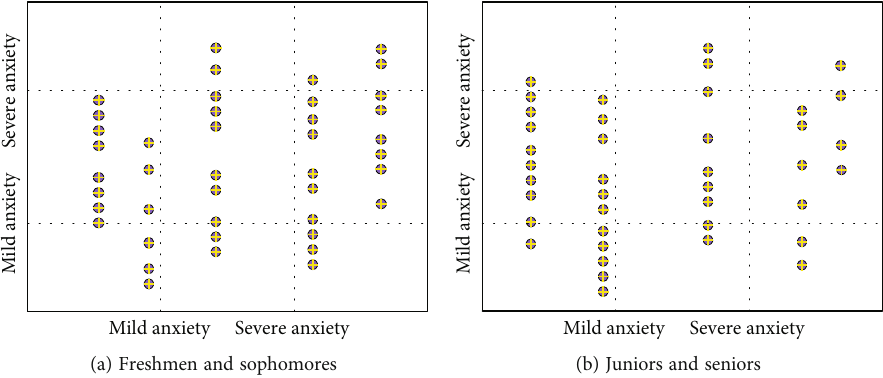
Figure 2: Psychological changes of younger (a) and older (b) college students during the